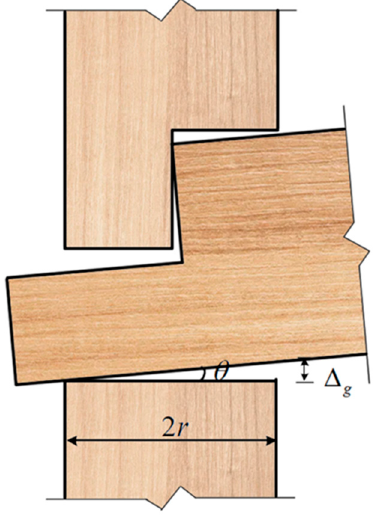
Figure 26. Free rotational